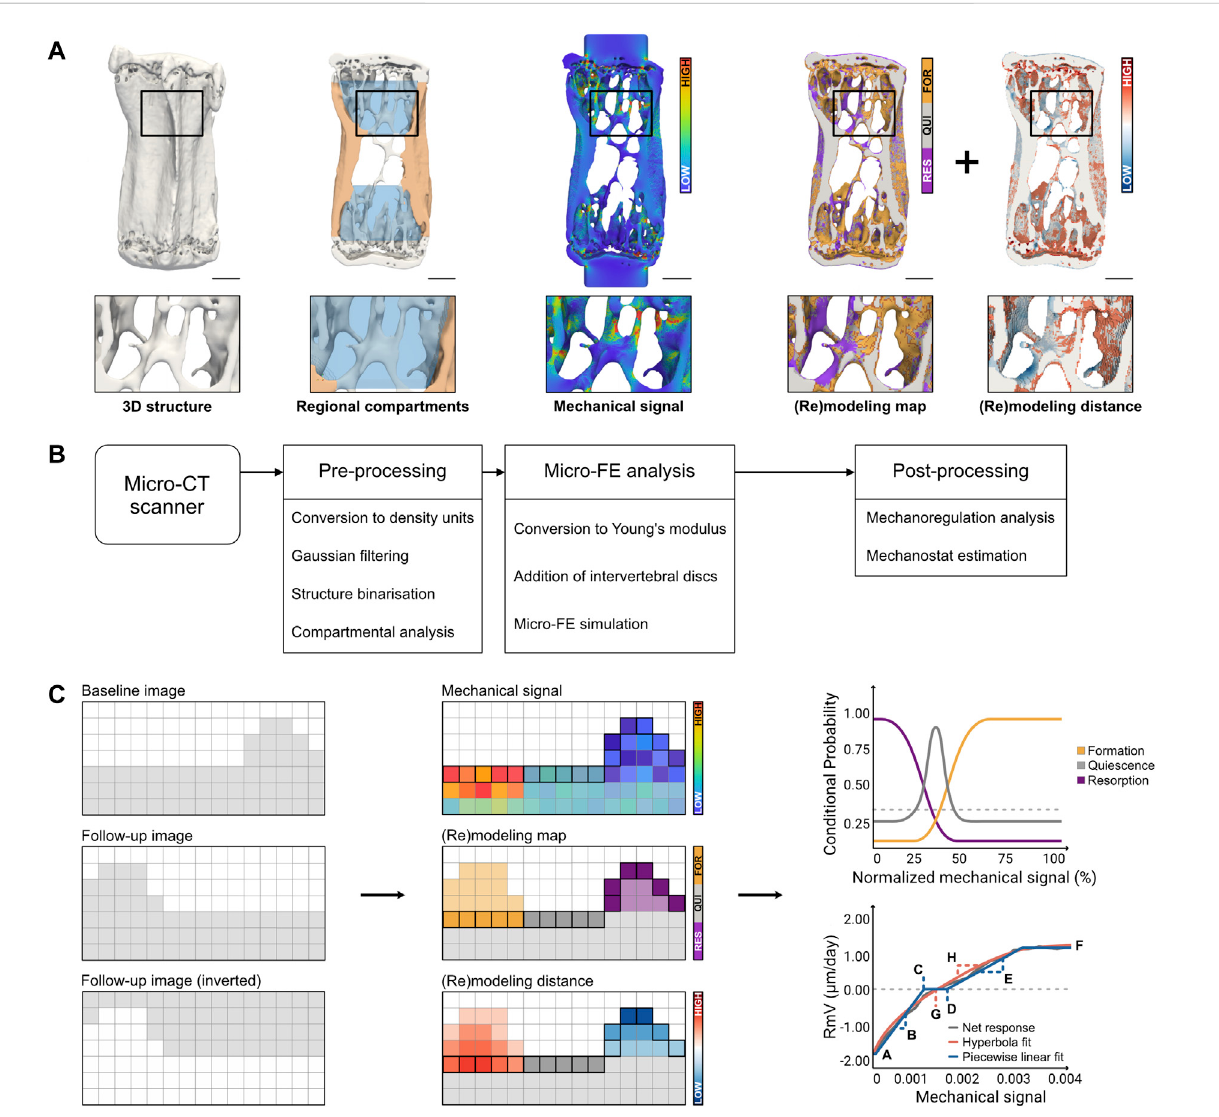
FIGURE 1 Overview of the computational pipeline for high-throughput analysis of time-lapsed in vivo micro-CT mouse caudal vertebrae samples. (A) Qualitative visualization of a representative sample highlighting the original bone structure, the identi fi cation of regional compartments (trabecular compartment in blue and cortical compartment in orange), the local mechanical signal computed as strain energy density (SED) from micro-FE analysis, the (re)modeling map obtained from time-lapsed micro-CT images and the (re)modeling distance associated with surface voxels (Scale bar: 500 µm). (B) Diagramofthework fl owincludedinthecomputationalpipeline,frompre-processingmicro-CTimagestopost-processingsteps,featuring mechanoregulation analysis. (C) Illustration of the work fl ow for mechanoregulation analysis and estimation of mechanostat parameters: the